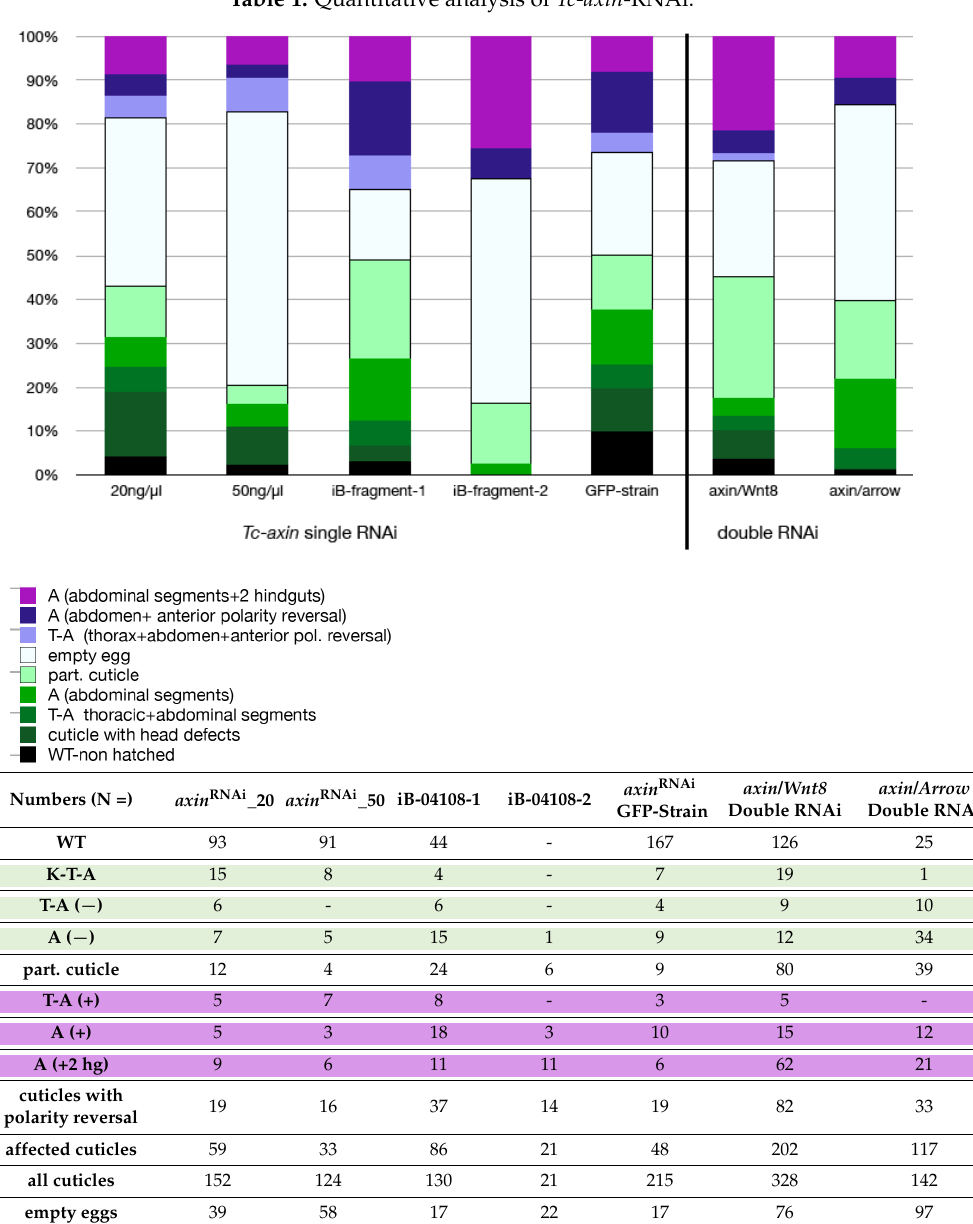
Table 1. Quantitative analysis of Tc-axin -RNAi.